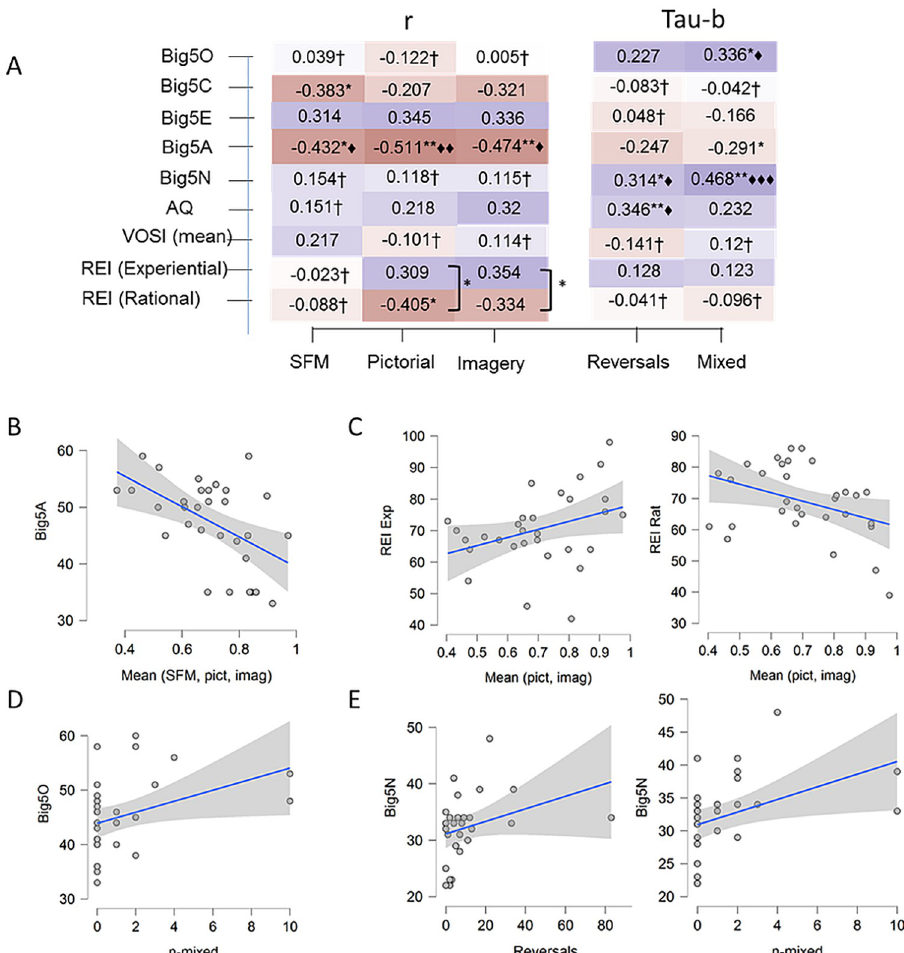
Fig 6. Heat-map and scatterplots. A. Correlations are shown between the influences of priming (SFM, still image, and imagery) and the personality traits (Pearson’s r), and number of reversals and mixed perceptions and personality traits (Kendall’s Tau-b). Tests are two tailed: � p < .05, �� p < .01, ♦ BF 10 > 3, ♦♦ BF 10 > 10, ♦♦♦ BF 10 > 100 (in support for a correlation). The sign † indicates cases where the result is 3 to 5 times more likely due to an absence of a correlation than if there was a correlation in the population. The staples between the experiential and rational cognitive styles indicate significant differences between correlations. B. Scatterplot between agreeableness scores and priming averaged across all three prime conditions. C. The scatterplots between the experiential and rational cognitive modes as scored by REI and the influence of the SFM-prime and the imagery-prime presented separately. D. The scatterplots between openness scores and the number of mixed percepts. E. Separate scatterplots are shown between reversals and neuroticism, and mixed percepts and